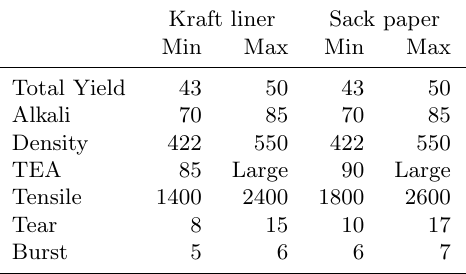
Table 4: Specifications for two different end uses of paper